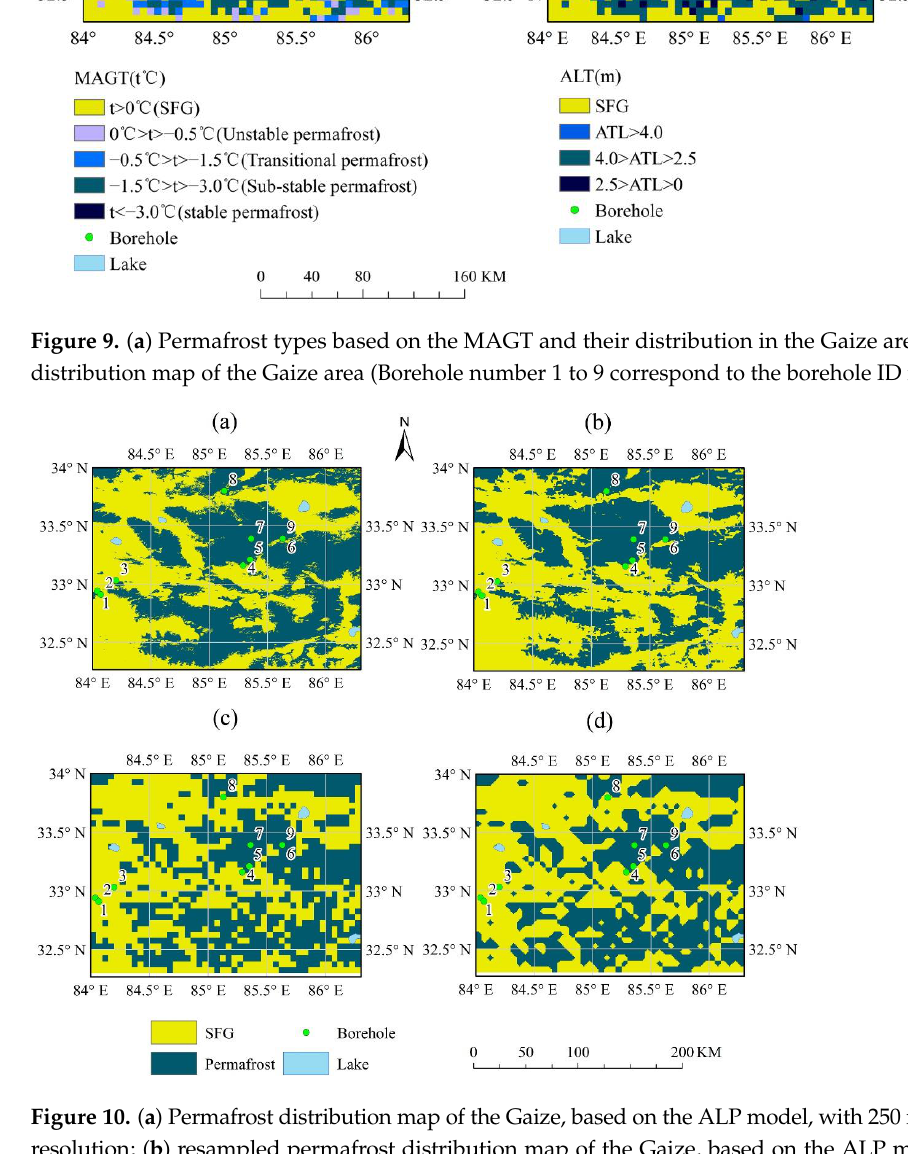
Figure 10. ( a ) Permafrost distribution map of the Gaize, based on the ALP model, with 250 m × 250 m resolution; ( b ) resampled permafrost distribution map of the Gaize, based on the ALP model, with 1 km × 1 km resolution; ( c ) permafrost distribution map of the Gaize, based on the MAGT model, with 5 km × 5 km resolution; ( d ) resampled permafrost distribution map of the Gaize, based on the MAGT model, with 1 km × 1 km resolution (Borehole number 1 to 9 correspond to the bore- hole ID in Table 1).